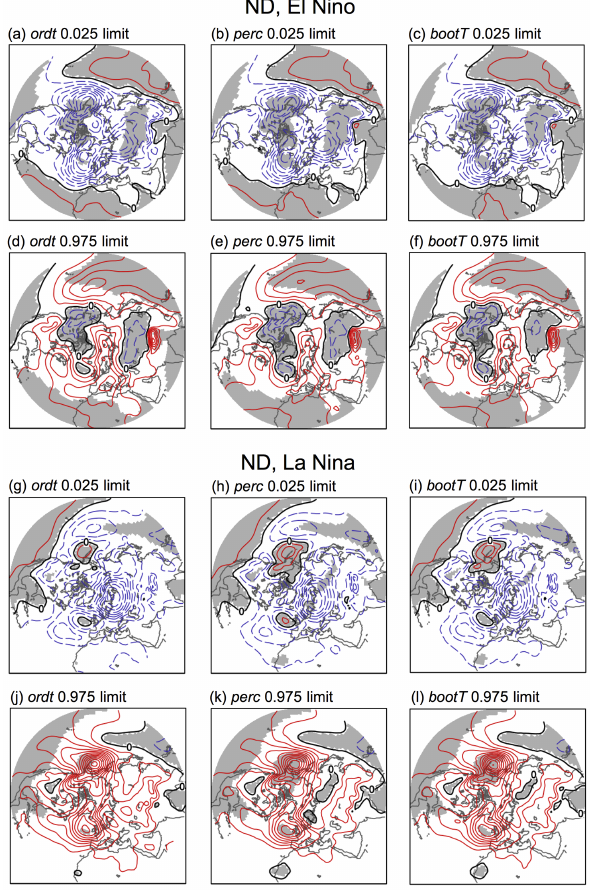
Figure A6. Lower and upper limits of confidence intervals (at 95% level) for ND El Niño and La Niña SLP composites corresponding to Fig. 5a and b. The ordt , perc , and bootT intervals are described in Sect. 3.3. The contour interval is 0.5hPa, with red (blue) con- tours indicating positive (negative) anomalies. Gray shading indi- cates locations where the SLP anomalies have the same sign within the entire interval.